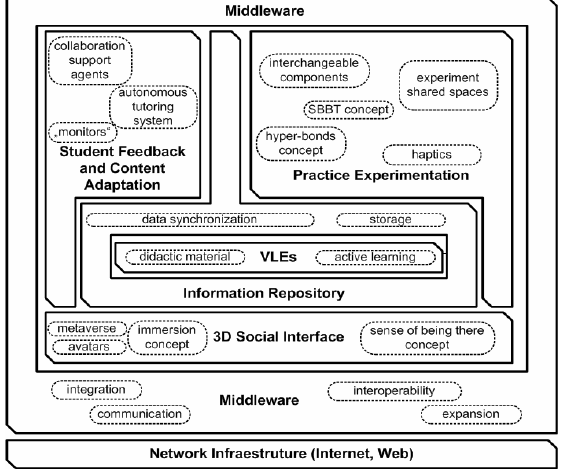
Figure 1. Concept modules diagram of the CSCE architecture